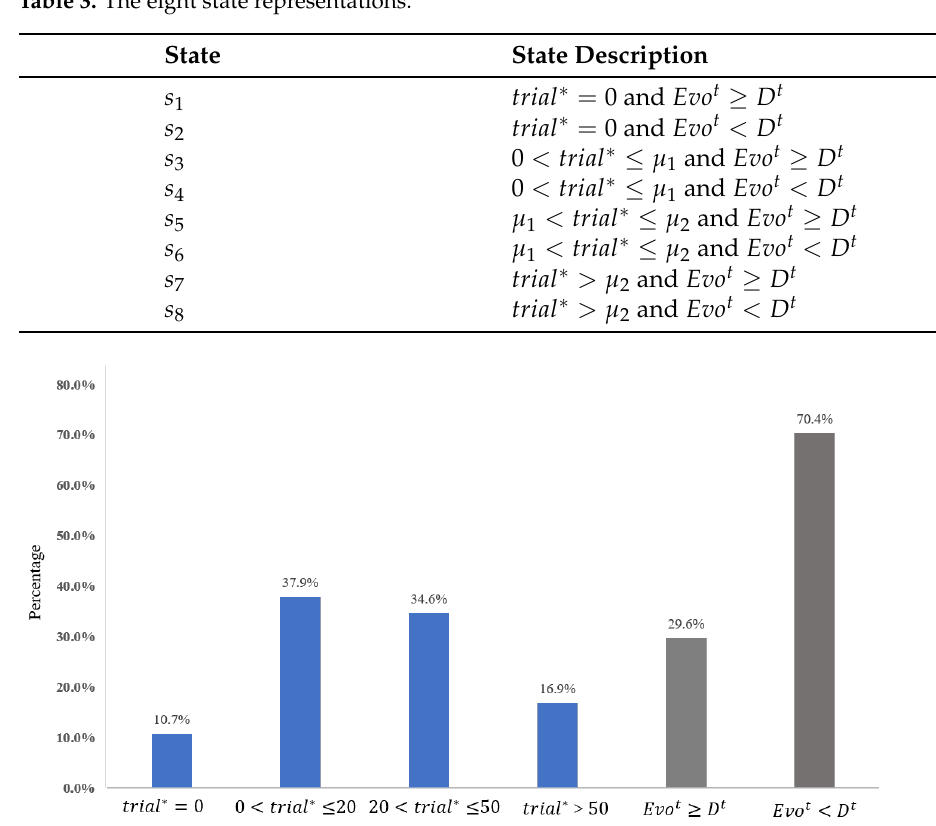
Figure 6. Four cases on trial ∗ and two cases of Evo t and D t .